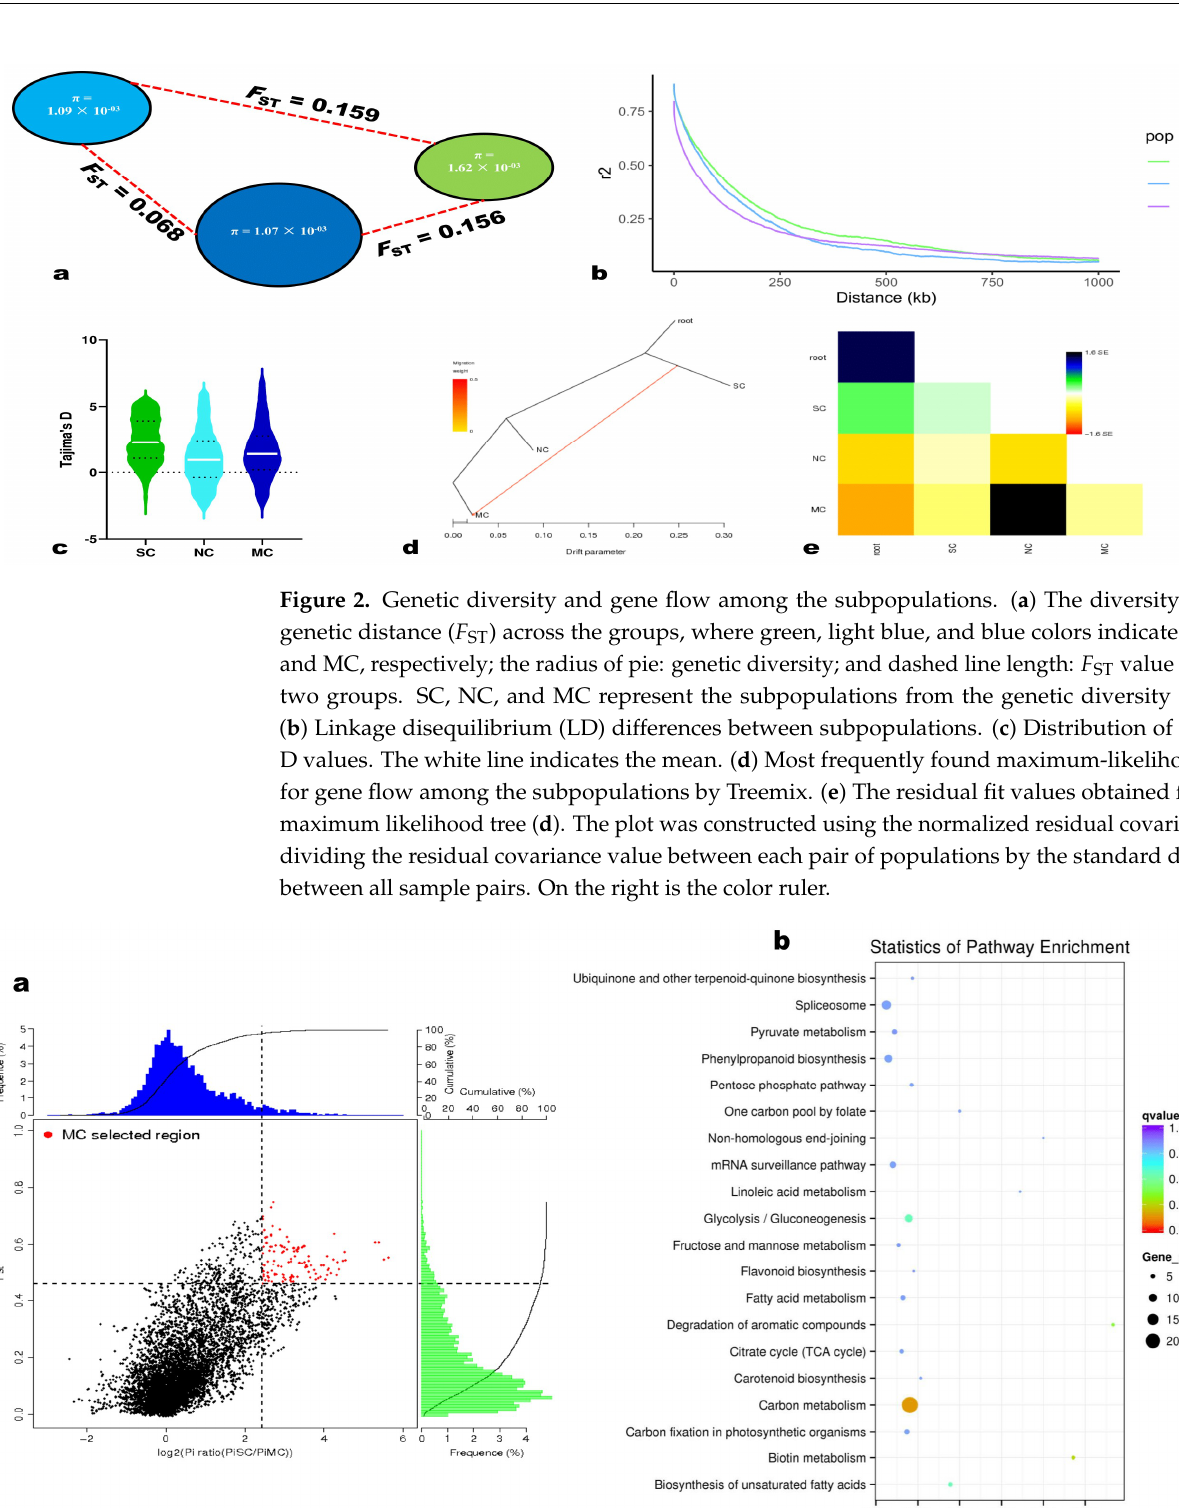
Figure 3. Selective sweeps and functional characterization of positively selected genes in MC group. ( a ) Selection signatures in MC subpopulation. Each red dot indicates a positive selectivegenomic region. ( b ) KEGG (Kyoto Encyclopedia of Genes and Genomes) analysis and enrichment results of genes detected under selective genomic regions in MC subpopulation. The color ruler and p -values are shown on the right.